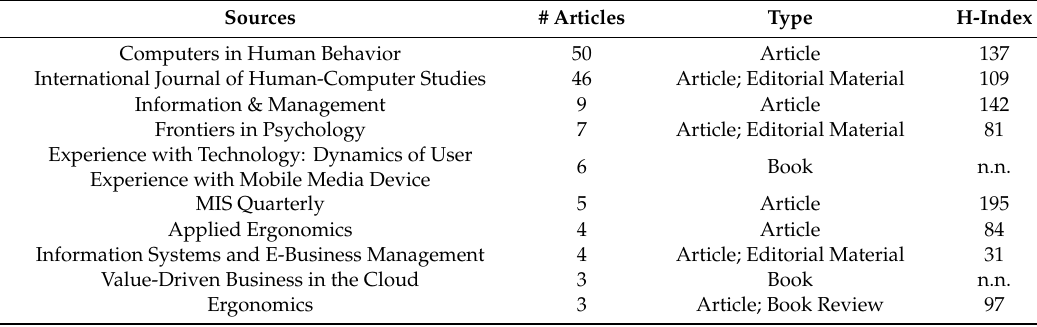
Table 2. Top ten most productive sources. Source: Own elaboration based on WoS.